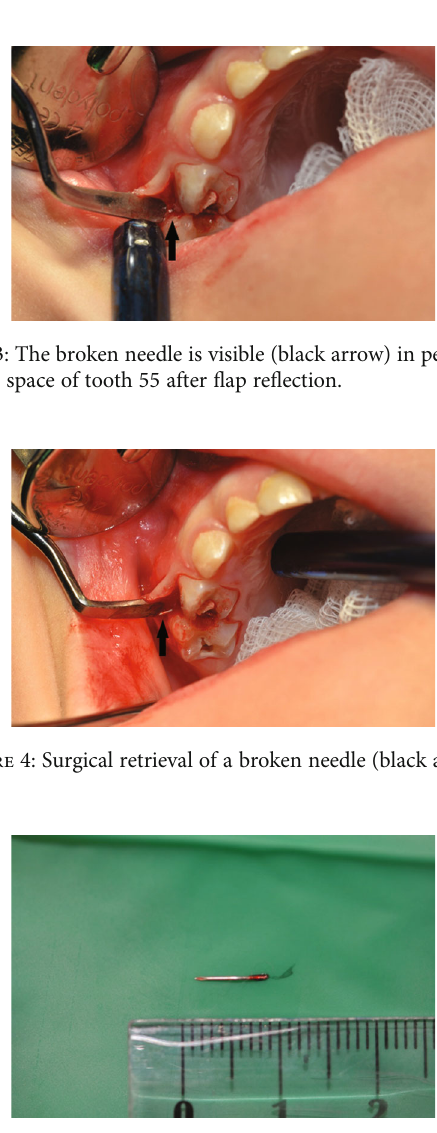
Figure 5: Removed needle, approximately 8mm